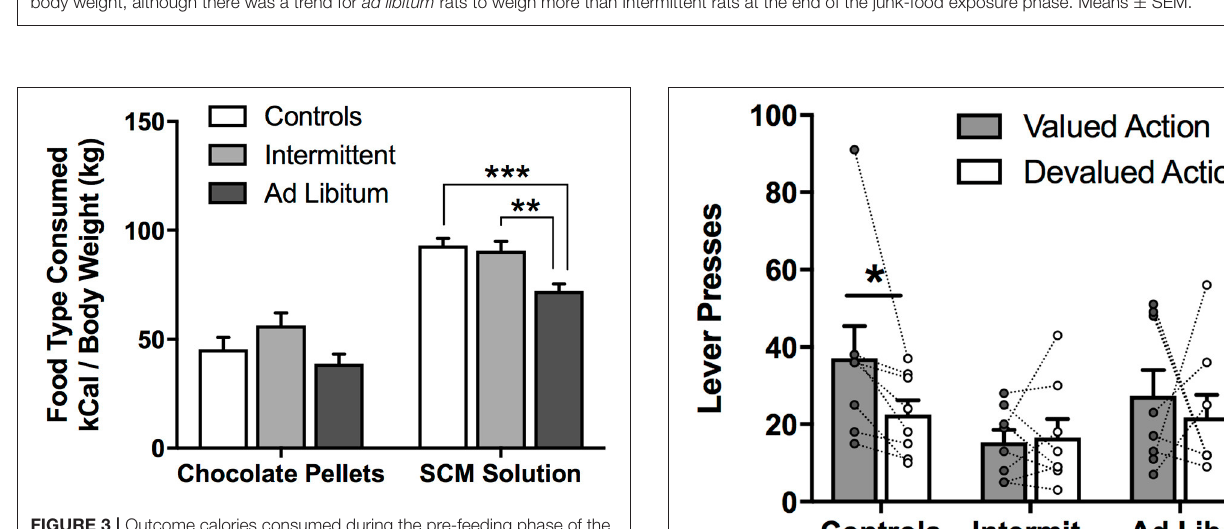
FIGURE 2 | Changes in body weight. (A) Final body weights after the junk-food exposure phase. (B) Weight gained during the junk food exposure phase, expressed as a percentage of individual starting weights. There was no significant difference between diet groups in final body weight or weight gain as a percentage of initial body weight, although there was a trend for ad libitum rats to weigh more than Intermittent rats at the end of the junk-food exposure phase. Means ± SEM.